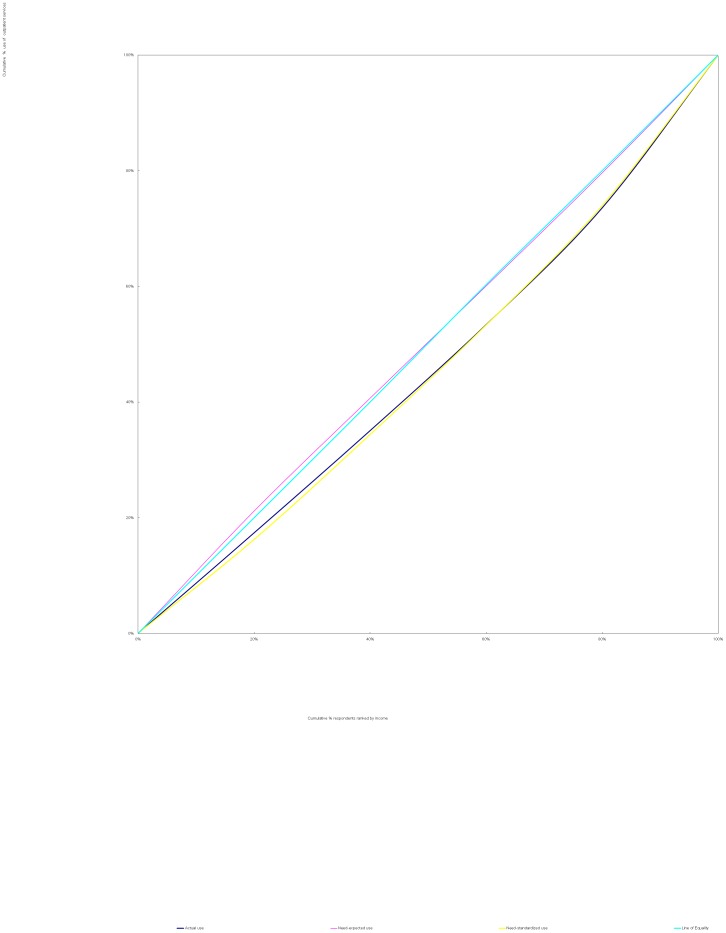
Concentration curves for use of outpatient services, China 2008.The line of need-expected services lie nearer to equality line. Both lines of actual use and of need-standardized services lie below the equality line and almost coincide with each other.